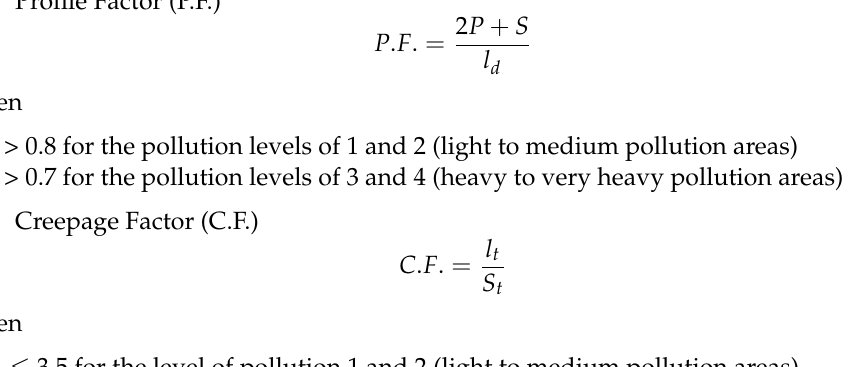
Figure 2. Schematic diagram of the main nanotechnology design concepts for outdoor